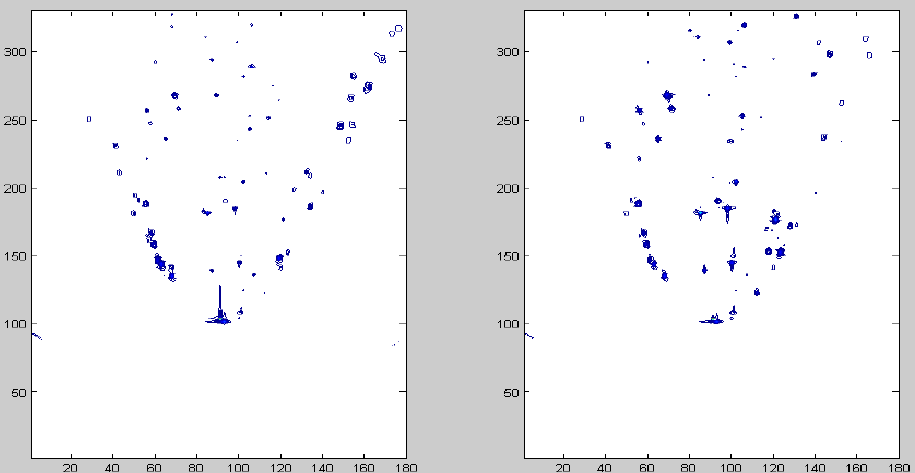
Fig. 12. Comparative images for two-channel radar with continuous-waveform